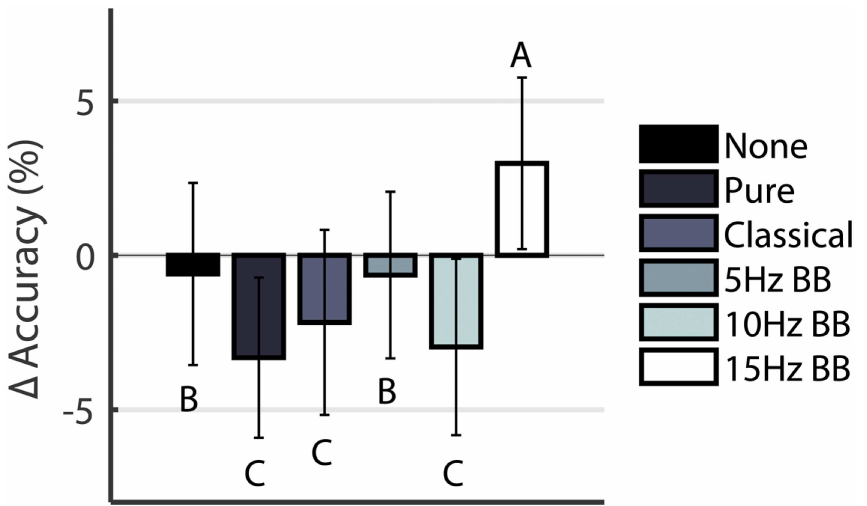
Fig 3. Δ Accuracy. Conditions marked with different letters are significantly